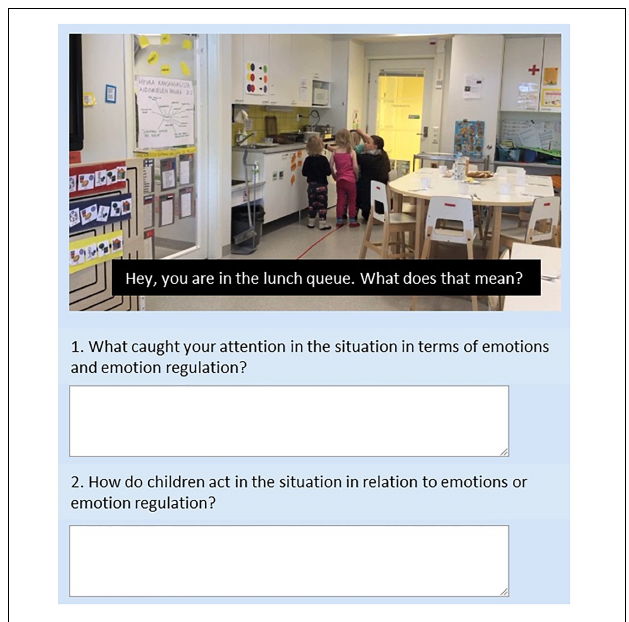
FIGURE 6 | A screenshot from a part of online